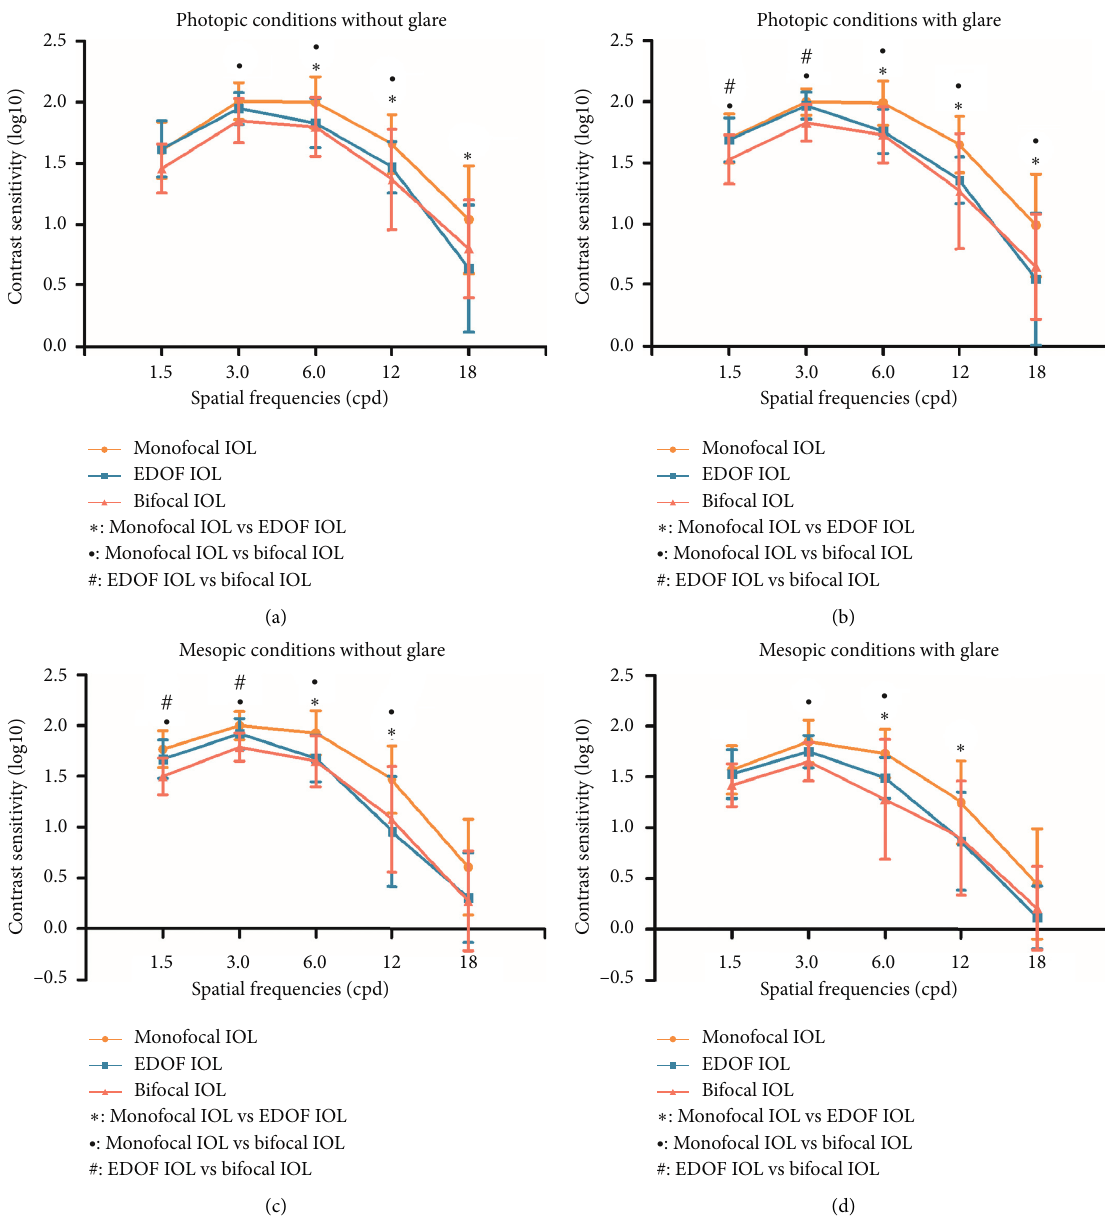
Figure 4: Comparison of the mean contrast sensitivity (CS) values among the 3 intraocular lens (IOL) groups at different spatial frequencies under photopic conditions without glare (a), mean CS values under photopic conditions with glare (b), mean CS values under mesopic conditions without glare (c), and mean CS values under mesopic conditions with glare (d). Error bars represent the standard deviation (SD) of the mean ( ● � statistically significant difference between the monofocal group and the extended-range-of-vision (EDOF) group [ P < 0 . 05 ] ; # � statistically significant difference between the monofocal group and the bifocal group [ P < 0 . 05 ] ; ∗ � statistically significant difference between the EDOF group and the bifocal group [ P < 0 . 05 ]